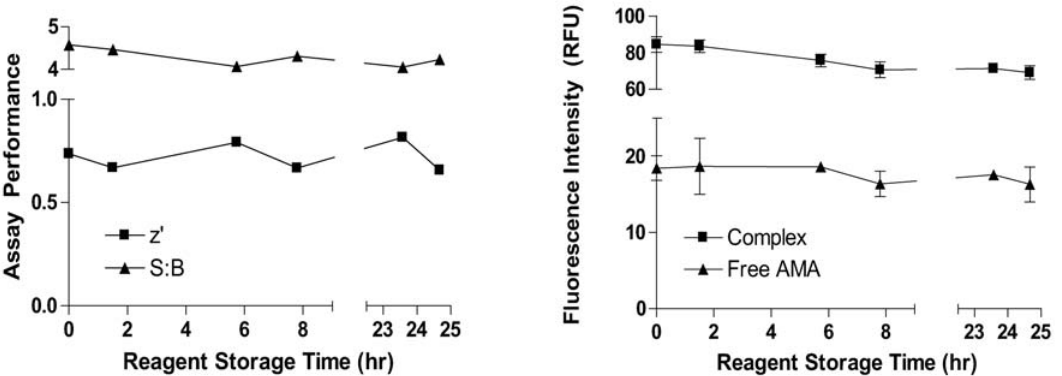
Figure 2. Assay stability. Bottles with free 1-AMA or complex were stored at 4 u C, connected to a liquid dispenser at shown time points, and the assay performed as described above. Fluorescence intensity, signal-to-background ratios (S:B) and Z’ factor were computed from 64 column 1,2 wells (complex) and 64 column 3,4 wells (free 1-AMA).